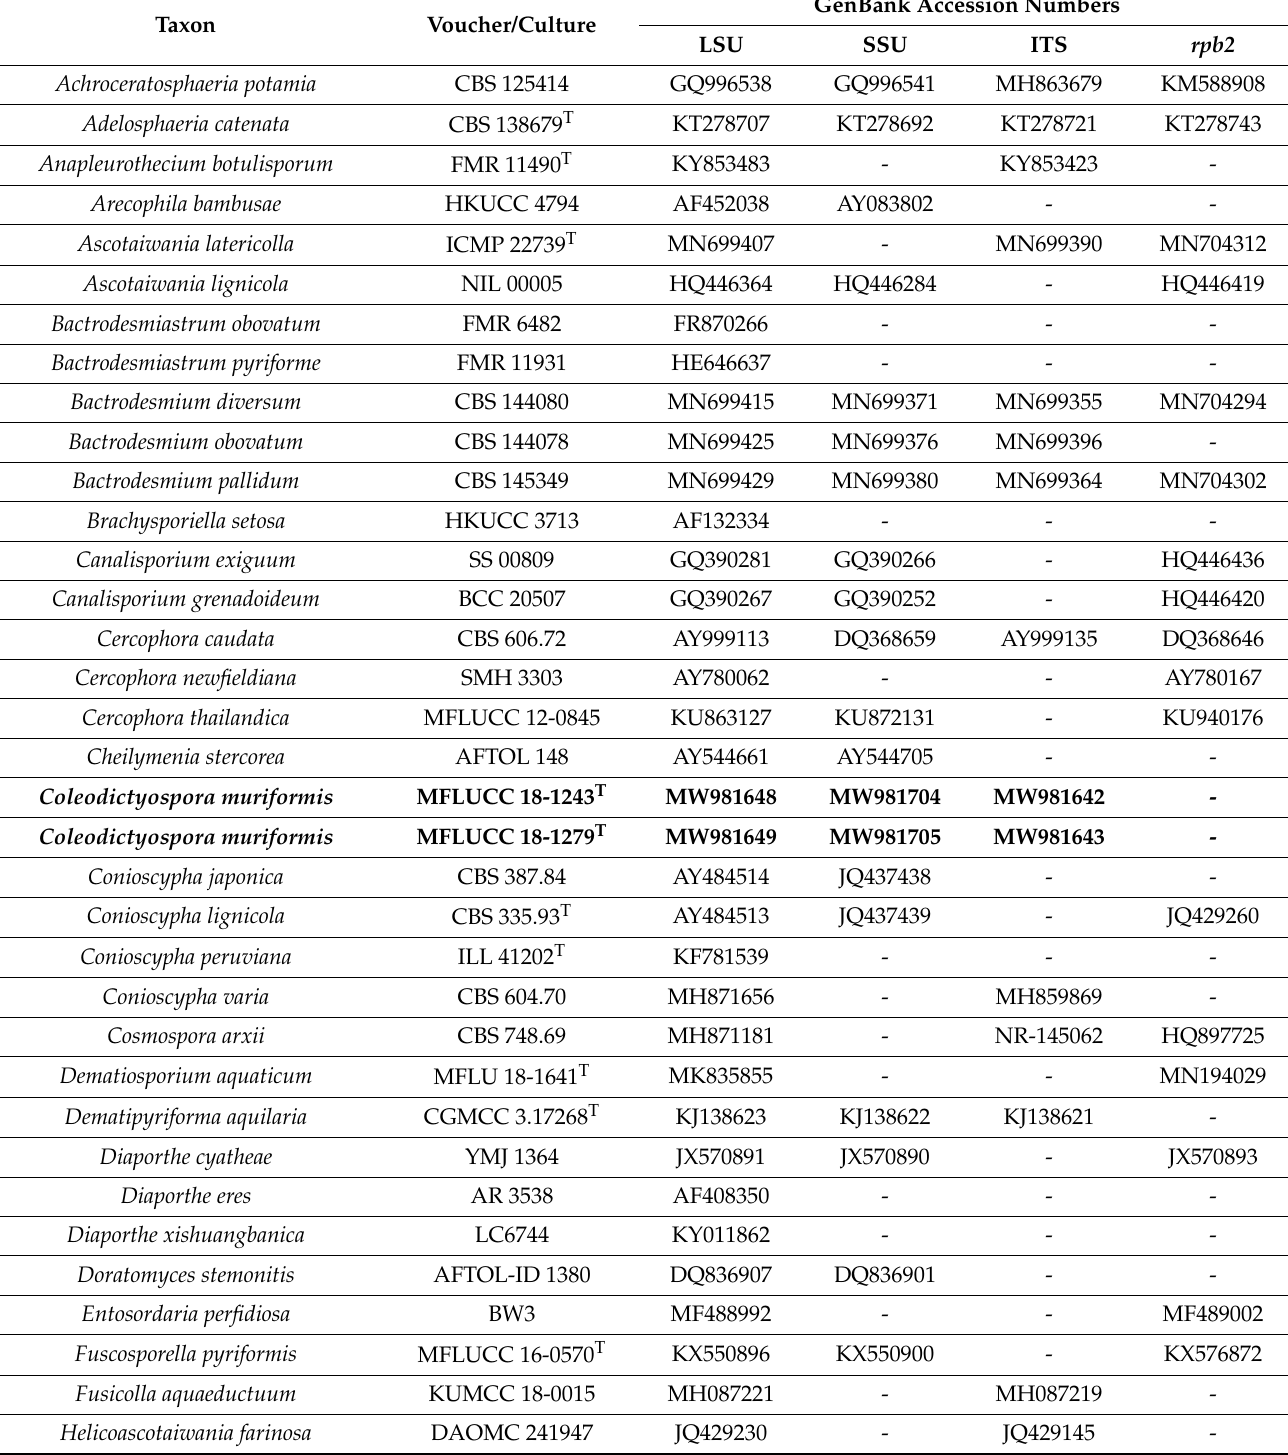
Table 1. Taxa used in the phylogenetic analyses and their corresponding GenBank accession